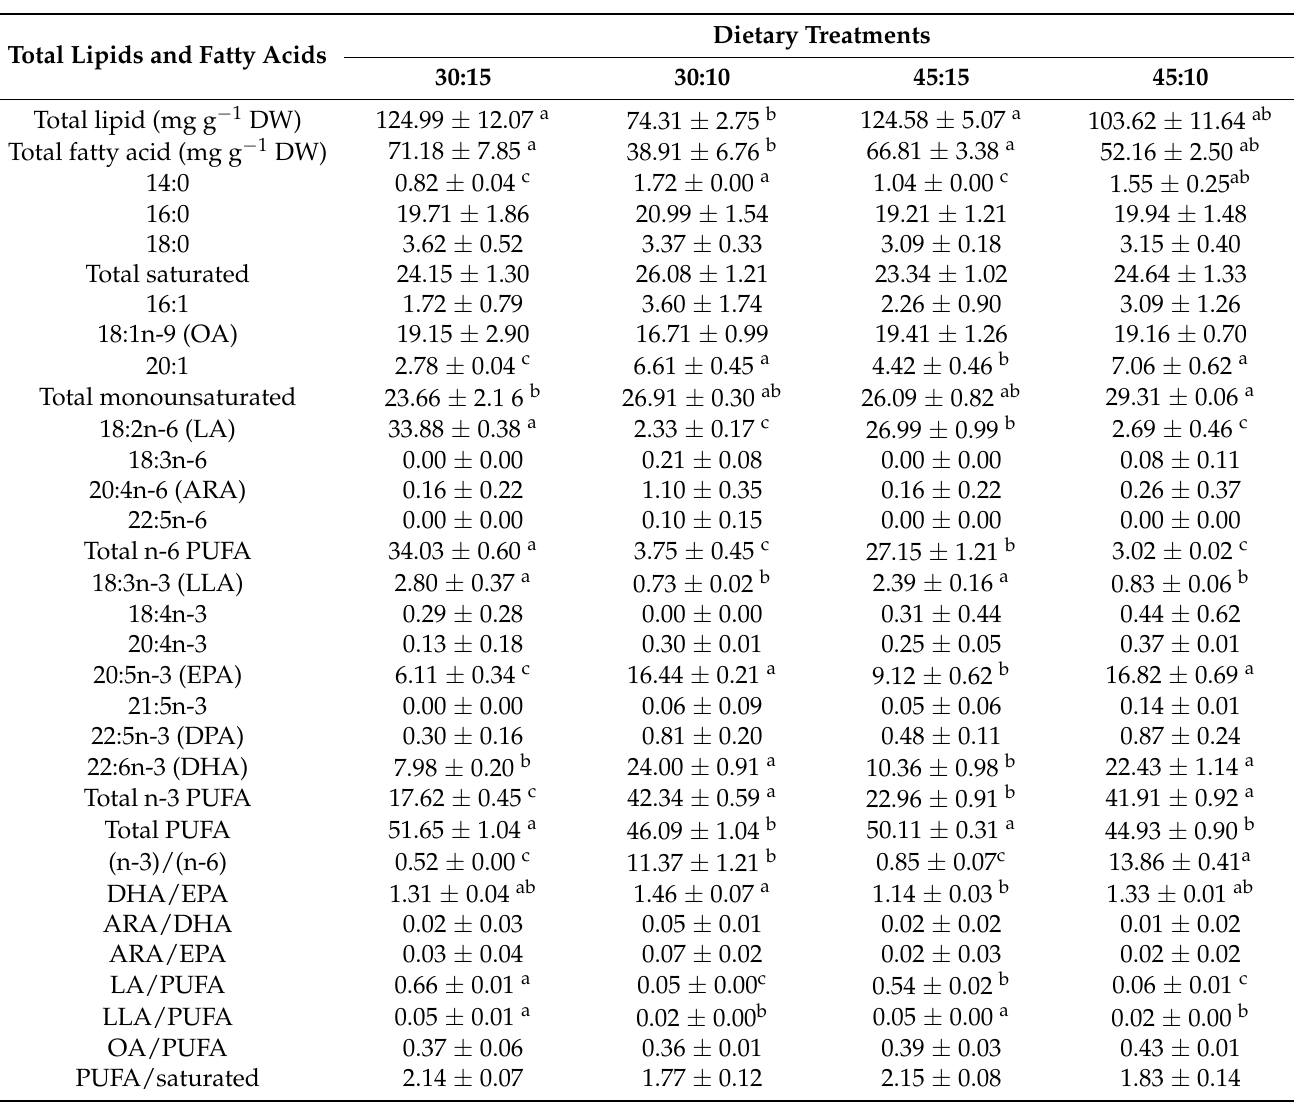
Table 5. Total lipid and total fatty acids contents (in % of dry matter) and fatty acid composition (in % TFA) analyzed in the experimental diets. Data are expressed as mean ± S.D. ( n = 3). Different superscript letters denote the presence of differences statistically significant between dietary treatments (one-way ANOVA, p < 0.05). Dietary treatment codes correspond to the protein:lipid level included in the tested